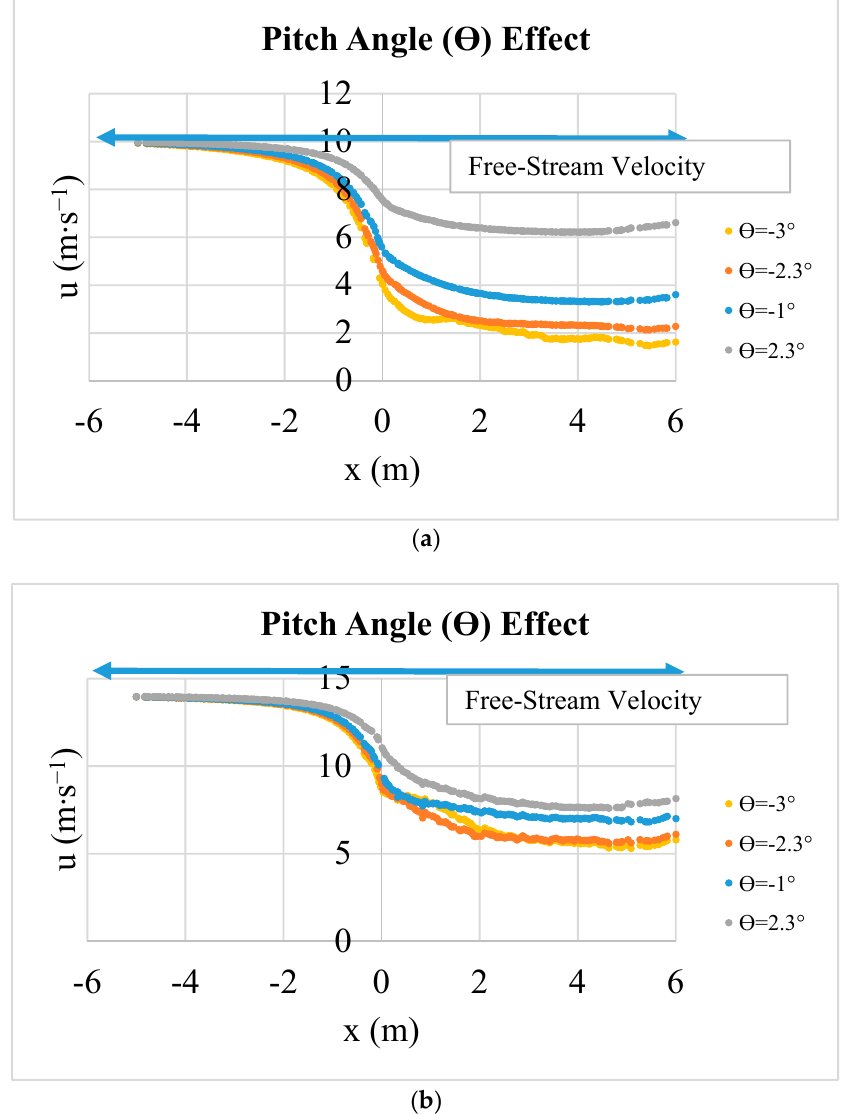
Figure 13. Influence of the pitch angle ( θ ) in the wake for: ( a ) U = 10 m ∙ s − 1 ; ( b ) U = 15 m ∙ s − 1 . The designed pitch angle is θ = − 2.3°.